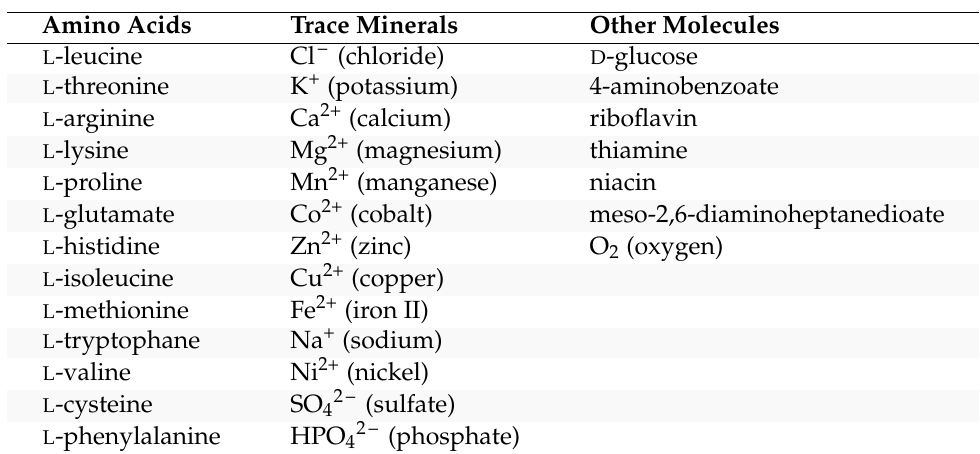
Table 2. Definition of a minimal medium for D. pigrum . Since D. pigrum holds many auxotrophies and several requirements for its environment to grow, we defined a minimal medium containing all relevant metabolites. The minimal medium comprises in total 33 compounds, including the 13 amino acids that cannot be produced, 13 trace minerals, D -glucose as a carbon source, and additional vitamins and required